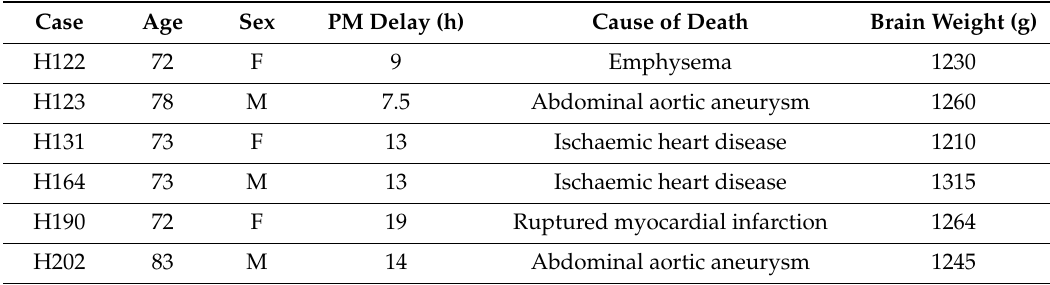
Table 1. Details of control cases for NanoString nCounter